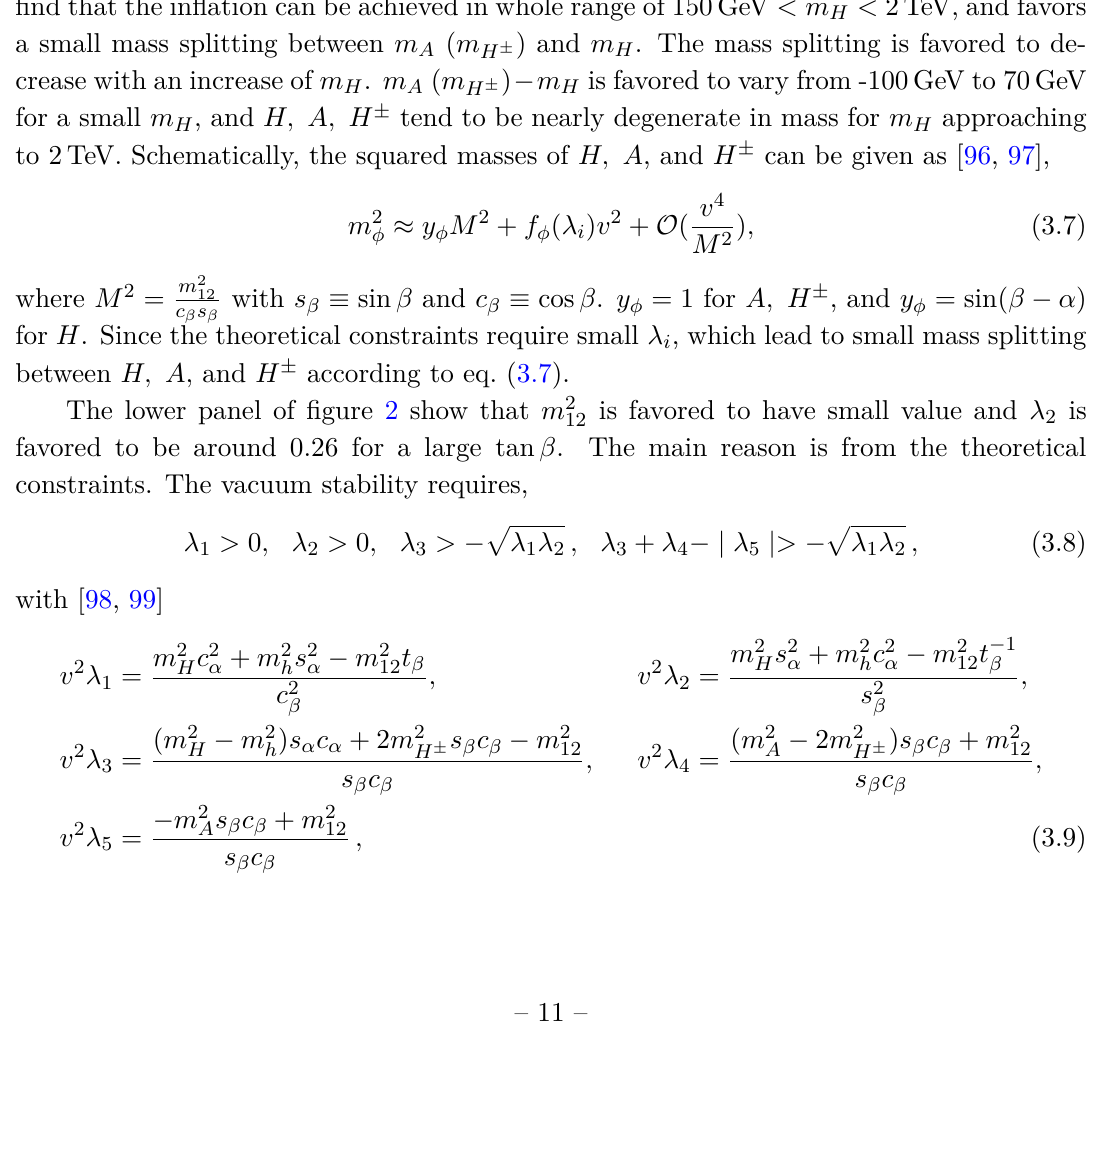
Figure 1 . For the type-I model, scatter plots of λ inflation and h 2